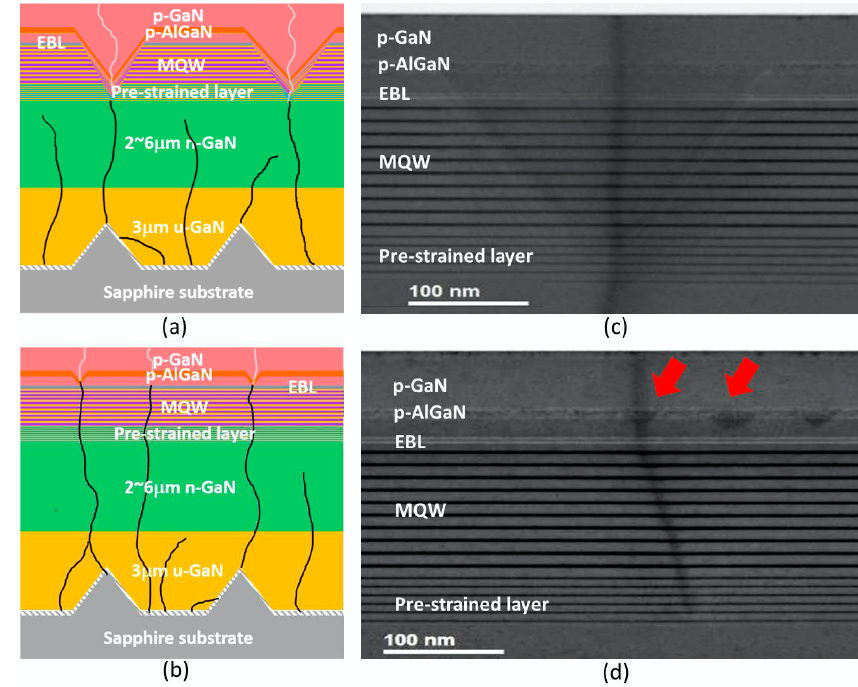
Figure 1. LED structures with ( a ) large V-pits originated from prestrained layers and ( b ) small V-pits originated after electron blocking layer (EBL). The black lines illustrate the propagation of threading dislocations. TEM images of LED samples with ( c ) large V-pits and ( d ) small V-pits (identified using red arrows).